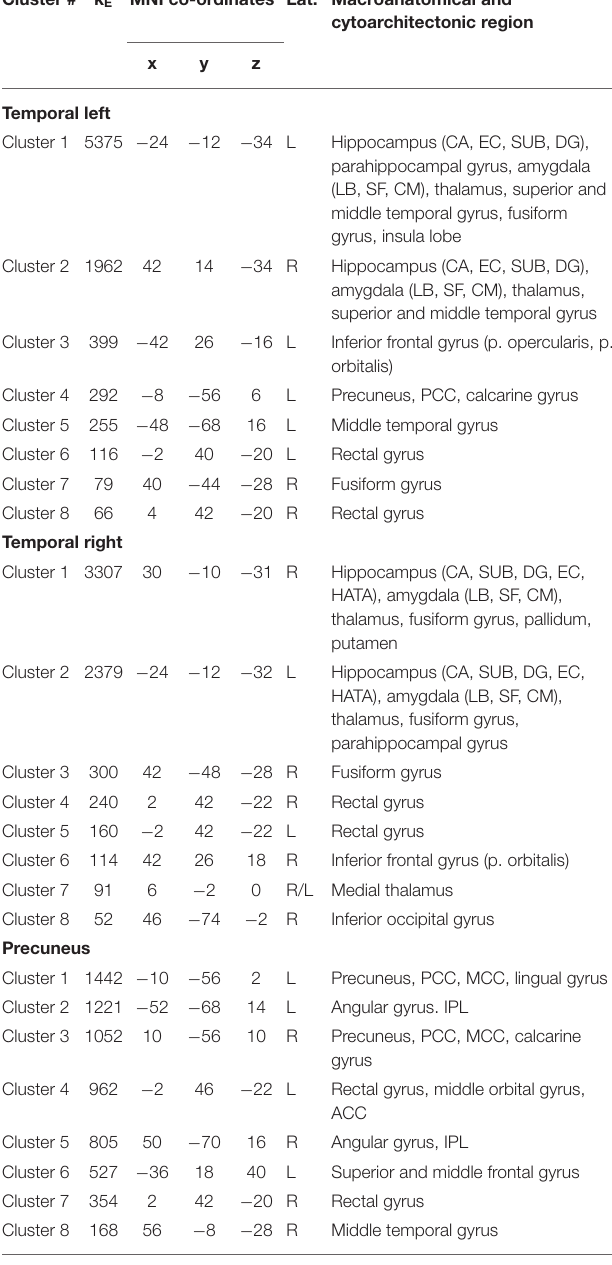
gyrus, left middle and superior frontal gyrus, and right middle temporal gyrus ( Figure 1D ; Table 1 ). Conjunction analysis